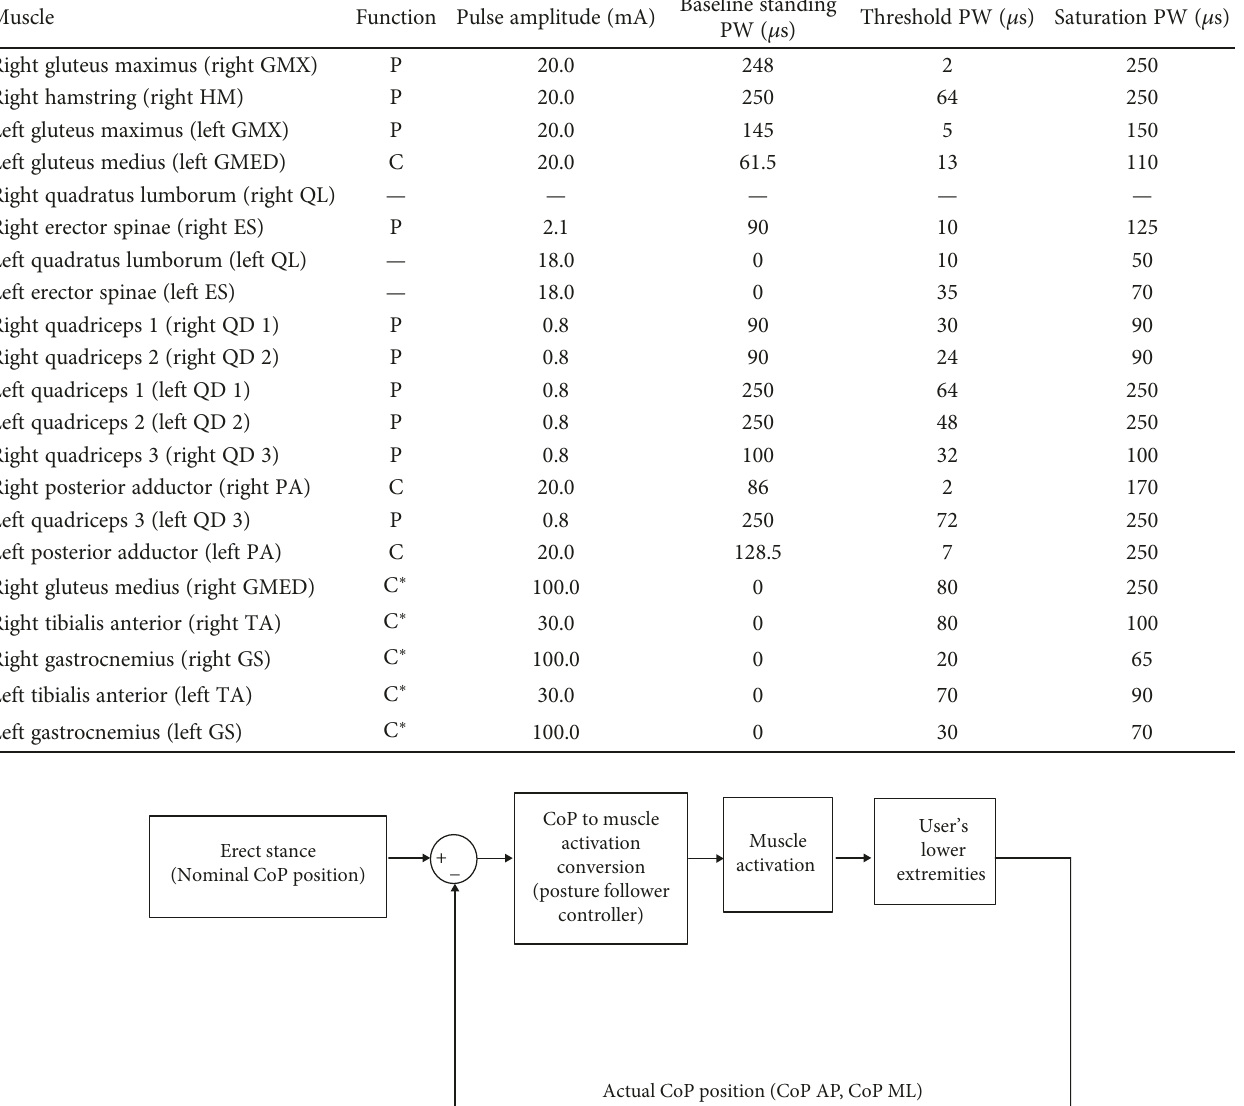
Table 1: Muscle pulse amplitudes and pulse widths for baseline standing. Muscles that were always recruited for baseline standing are indicated with a “ P ” , while those recruited by the controller are indicated with a “ C. ” Muscles that were supplemented with surface electrodes are indicated with a “ ∗ ” .